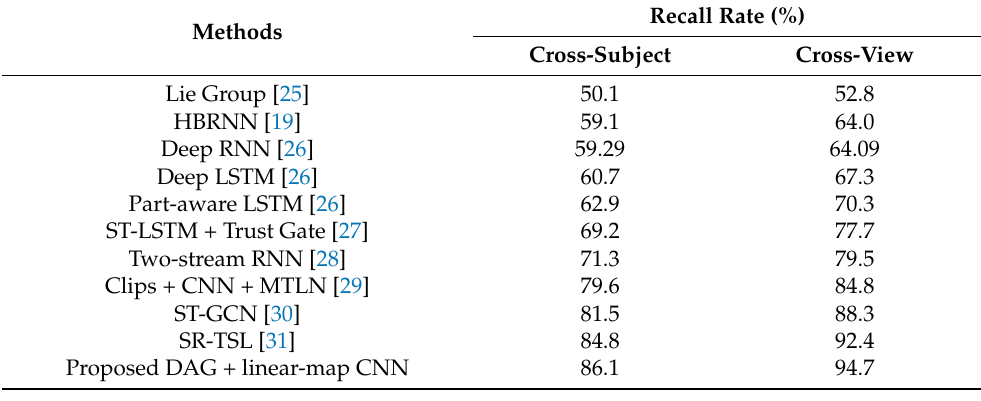
Table 9. These studies all used cross-subject and cross-view sources in the NTU RGB+D database to recognize the actions, which also used the three-dimensional characteristics of each posture as the input features [19,25–31]. Our method had the best recall rates in the cross-subject and cross-view sources at 86.1% and 94.7%.